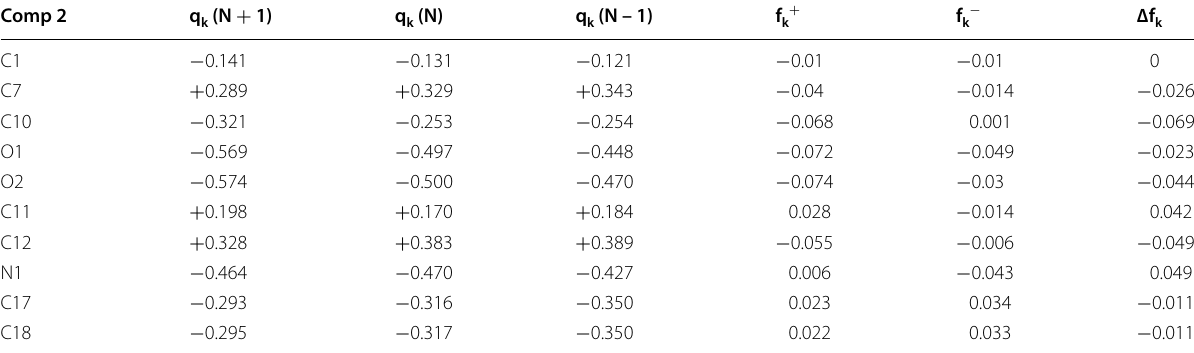
Table 3 Selected Mulliken atomic charges and Fukui functions for Compound